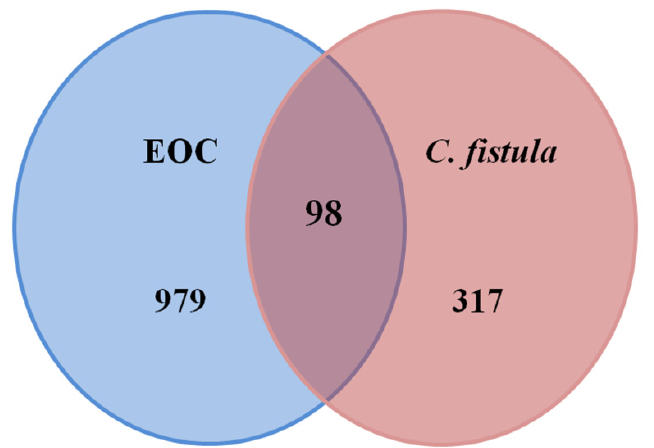
Figure 2. Venn diagram of potential targets.